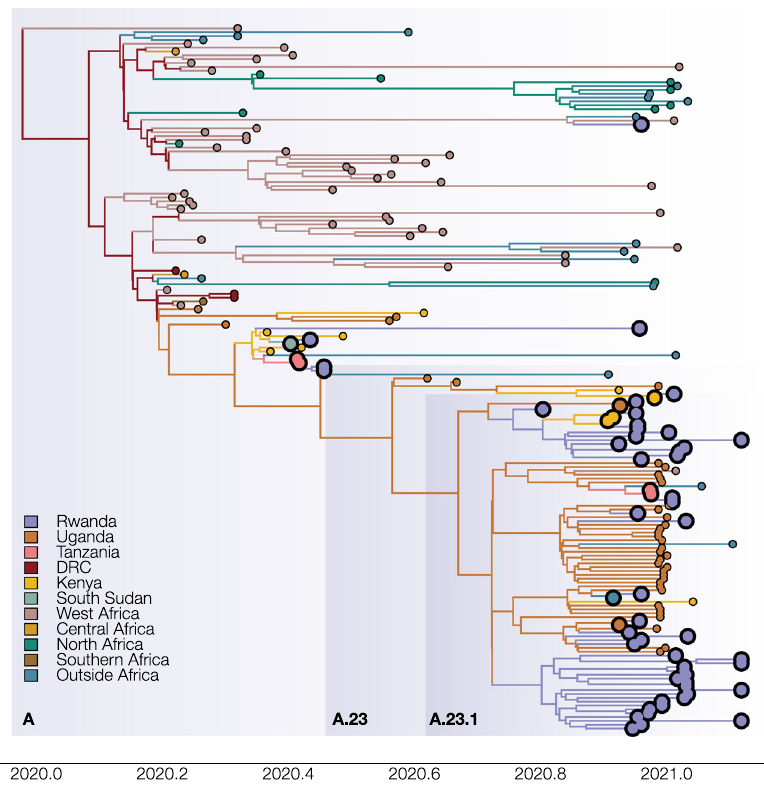
Fig. 5 Maximum clade credibility phylogeny for subtree A, representing diversity of lineages A.23 and A.23.1. The phylogeny with associated ancestral locations was inferred using travel history-aware asymmetric discrete state phylogeographic inference. A total of 33 locations were considered in the analysis but are grouped for visualization purposes. The branches in the phylogeny are colored according to the geographical location of the reconstructed ancestral regions. Rwandan sequences are indicated as large tips, colored by associated travel histories (available for 11 of the Rwandan sequences). The travel history-aware phylogeographic reconstruction on subtree A infers frequent mixing between Rwanda, Uganda, and Kenya, with the latter seeing introduction events from both Uganda and Rwanda. Both Kenya and Uganda are estimated to have seeded introductions into Tanzania, with the former also seeding an introduction into South Sudan. Importantly, the travel history-aware approach includes (returning infections from) Tanzania in lineage A.23.1, which could not be inferred via other phylogeographic